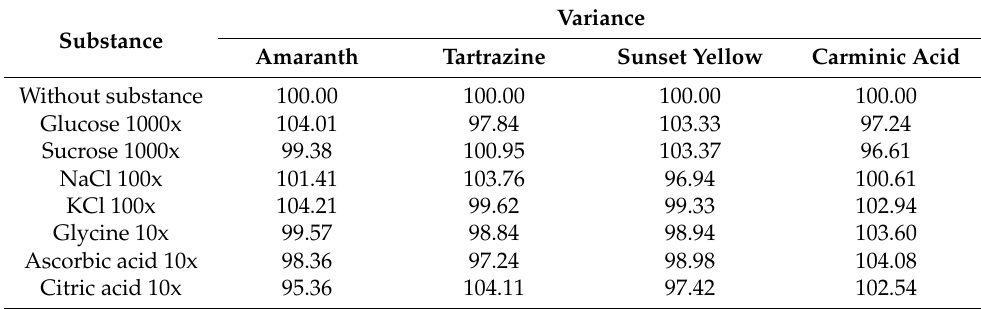
Table 4. Effect of interference substances on rGO-methionine/SPCE with dye concentration at 50 µ